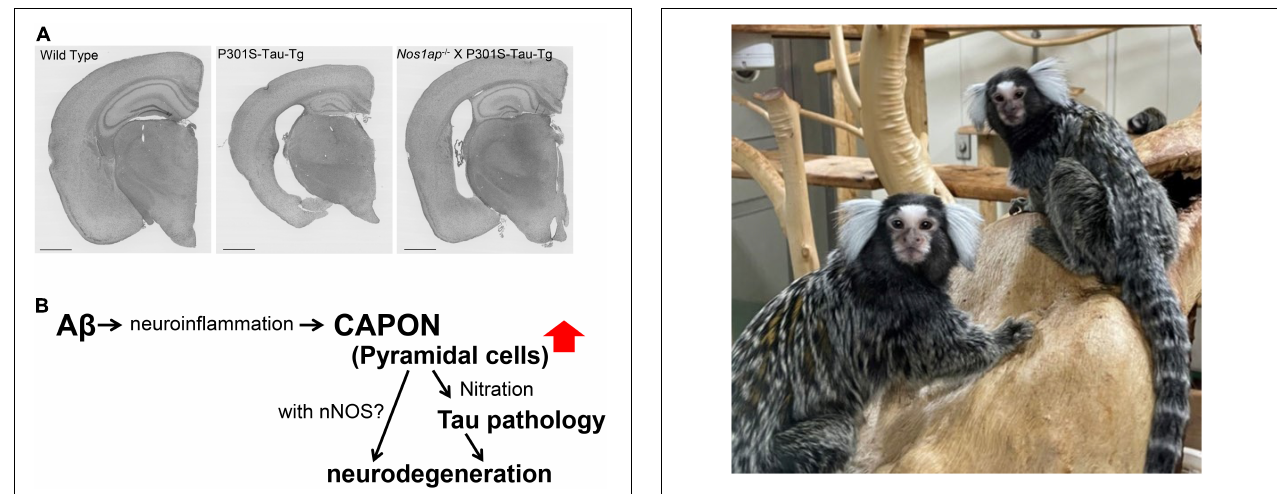
FIGURE 11 | Functions of CAPON in neurodegeneration. (A) Brain sections from WT, P301S-Tau-Tg or nos1ap -/-/P301S-Tau-Tg mice stained by the conventional method using hematoxylin and eosin (H&E). A CAPON ( Nos1ap ) deficiency restores AD-related pathological phenotypes in P301S-Tau-Tg mice. (B) Scheme of CAPON action. A β pathology elevates the level and localization of CAPON in hippocampal pyramidal cells. CAPON-induced neuronal cell death is closely associated with the pathological tau protein, although there appears to be a tau-independent mechanism in play as well.